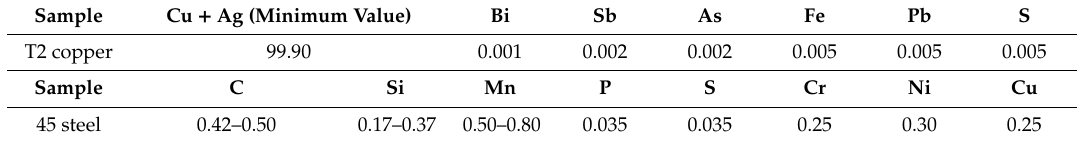
Figure 1. Welded sample. Table 2. Chemical composition of T2 copper [44] and 45 steel [45].